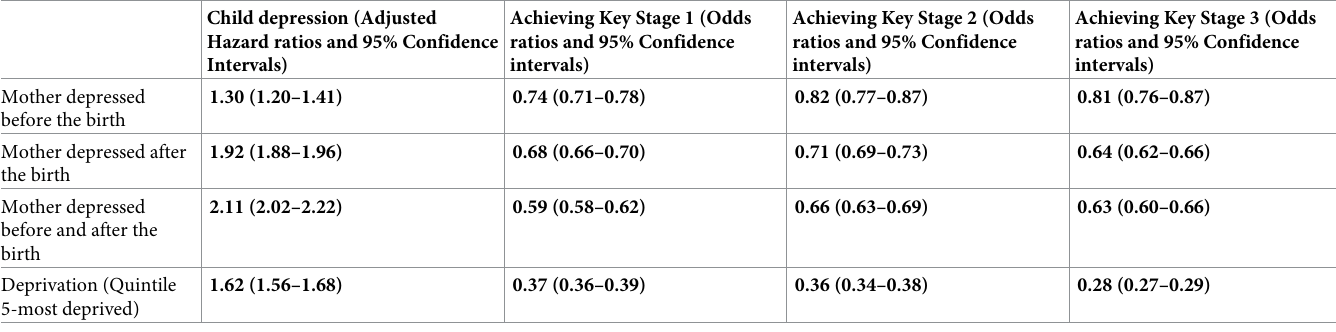
Table 3. Risk of depression in child if mother had depression, adjusting for deprivation (clustering on mother ID). Child depression (Adjusted Hazard ratios and 95%